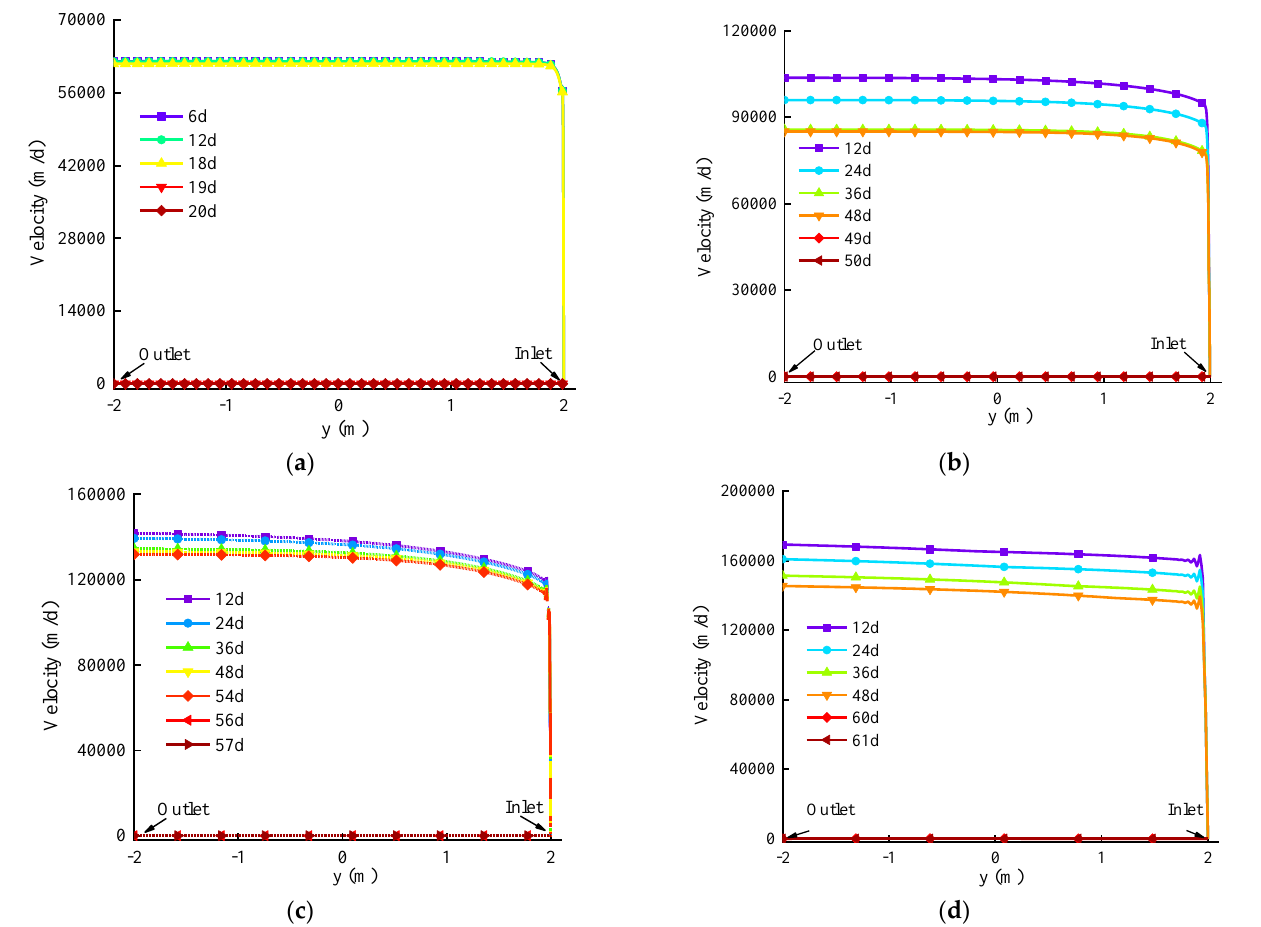
Figure 16. Interfacial velocity distributions at the fracture of single-fractured porous media rock mass during the liquid nitrogen reinforcement freezing process: ( a ) d f = 3 mm; ( b ) d f = 7 mm; ( c ) d f = 10 mm; ( d ) d f = 20 mm.